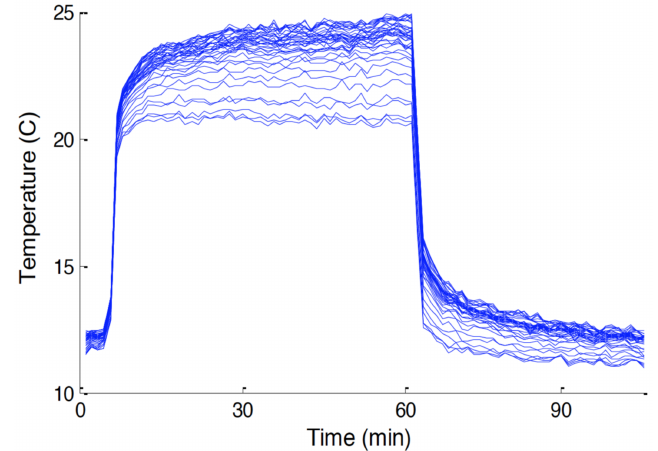
Figure 4. Reproduction of Figure 3.5 in Gregory [18] comparing heating results from 20 section of heated fiber optic cable under an infiltration gallery with spatially variable rates of flow. Locations with low flow continue heating, while those with significant flows